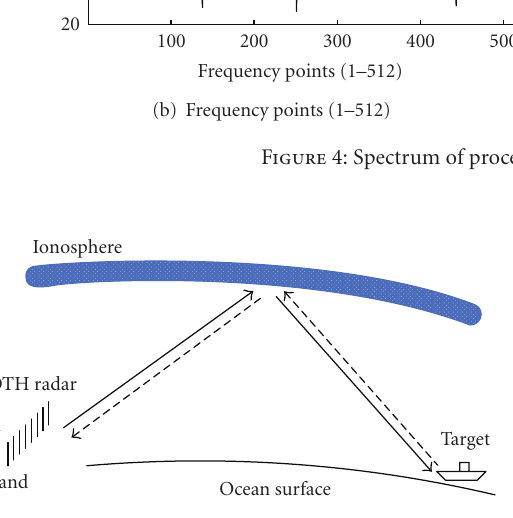
Figure 5: Demonstration of OTH Radar.